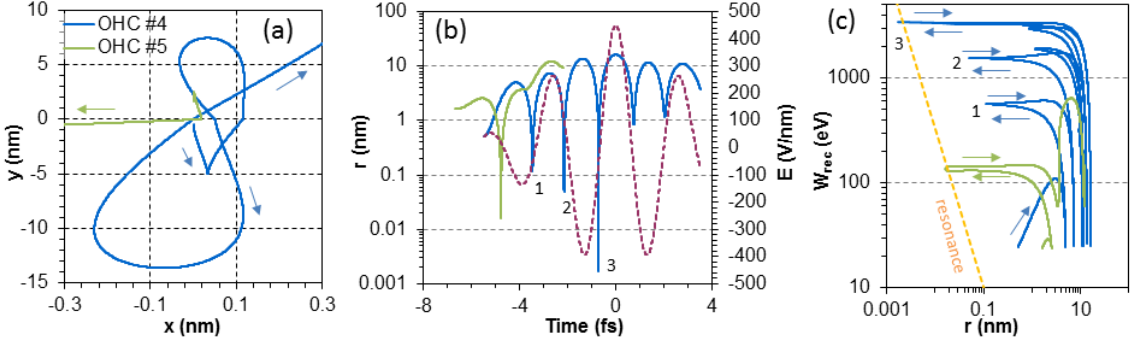
Figure 9. ( a ) Electron trajectories for a 6 fs-long laser pulse with a 2.5 × 10 16 W/cm² peak intensity. ( b ) Temporal evolution of the distance of the electron from the ion. The red dashed line is the electric field of the laser pulse. ( c ) Recombination energy of the electron during its flight for the two possible